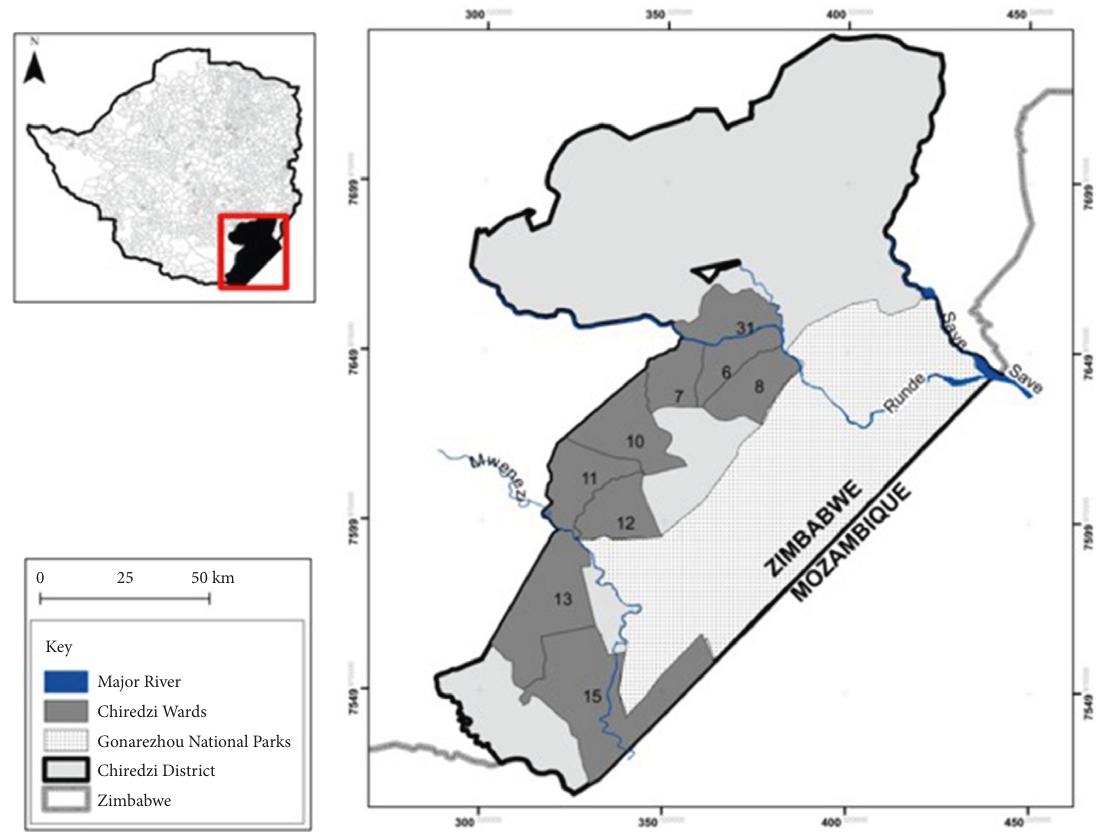
Figure 1: Location of the study area, i.e., Malipati Communal Area (Ward 15), southeast Zimbabwe. Source: Mwera [21]. Local community perceptions of riparian based ecosystem goods and services in the face of climate change: a case study of rural communities living on the edge of Mwenezi River, southeast Zimbabwe. Unpublished MSc thesis. Chinhoyi University of Technology,